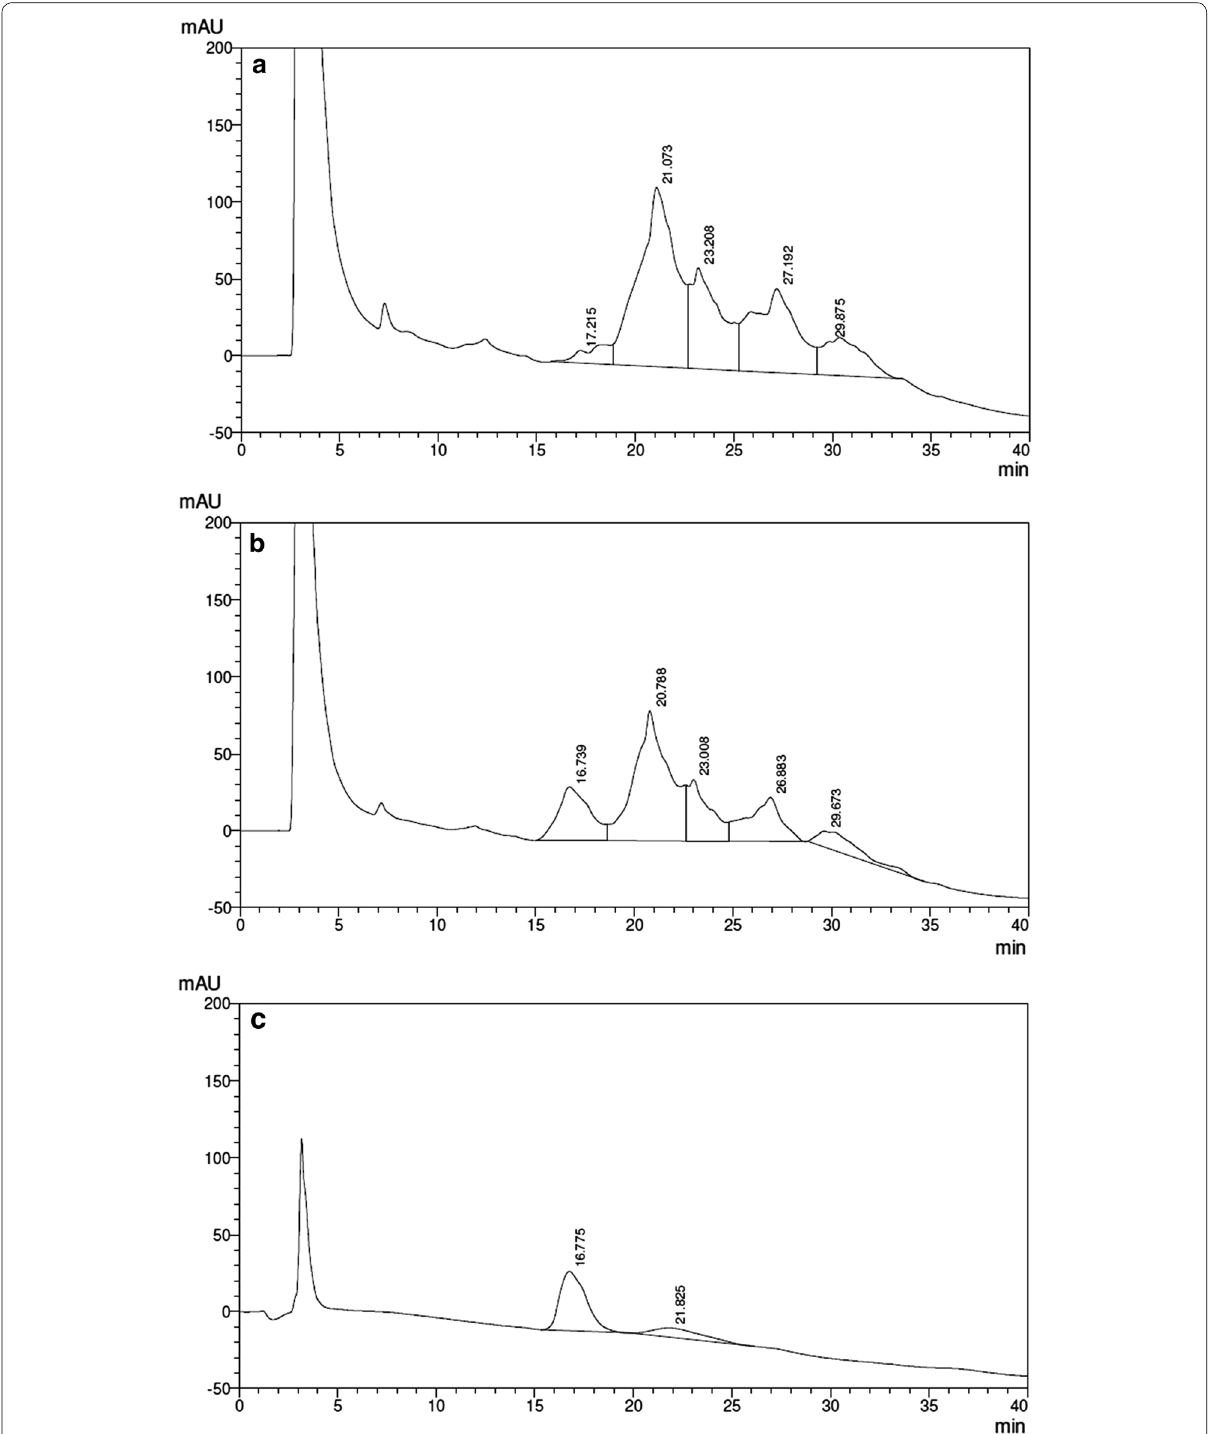
Fig. 4 RP-HPLC quantitative and qualitative analysis of E. coli -derived hBMP-2: a hBMP-2-containing conditioned medium, 100 μL; b same conditioned medium to which a known amount (10 μg) of the GenScript reference preparation was added; c GenScript reference preparation (10 µg), used for quantitative